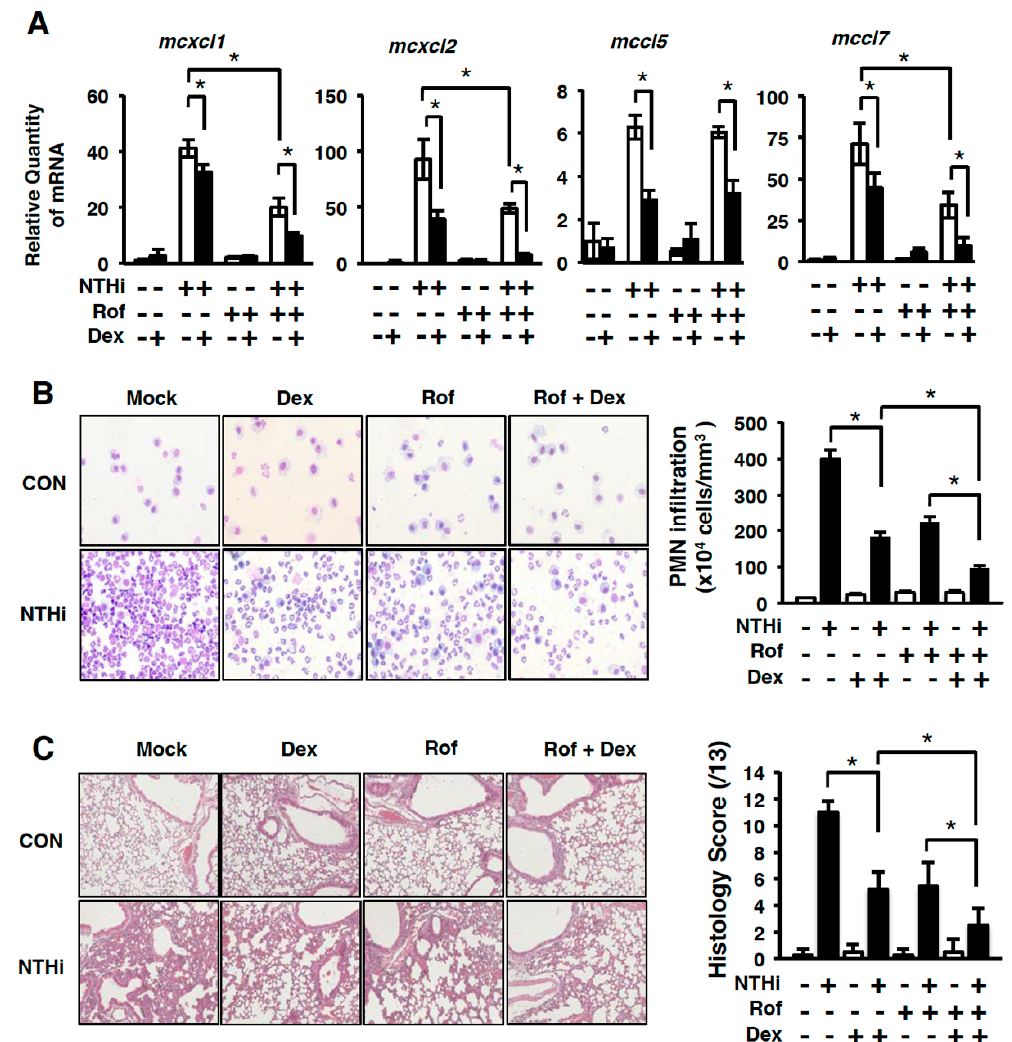
Figure 2. Dexamethasone suppresses NTHi-induced infiltration of polymorphonuclear neutrophils (PMNs) and inflammation in mouse lung in vivo. ( A ) Mice were inoculated with Rof (5 mg/kg i.p.) and/or Dex (2 mg/kg i.p.) for 2 h, followed by intratracheal inoculation with NTHi (5 × 10 7 CFU/lung). After 5 h, mRNA expressions of pro-inflammatory mediators in lung tissues were analyzed by Q-PCR. The relative quantity of mRNA is relative to a house keeping gene GAPDH . Data in ( A ) are mean ± S.D. ( n = 3); * p < 0.05. ( B ) Mice were inoculated with Rof (5 mg/kg i.p.) and/or Dex (2 mg/kg i.p.) for 2 h, followed by intratracheal inoculation with NTHi (5 × 10 7 CFU/lung) for 9 h. Bronchoalveolar lavage (BAL) fluid was harvested and cells from BAL fluid were then cytocentrifuged and stained with Diff-Quik staining kit. (Magnification: 100 × ). The number of PMN cells from BAL fluid was counted by using a hemocytometer under the microscope. Data are mean ± S.D. ( n = 3); * p < 0.05. ( C ) The lung tissues were collected 9 h after NTHi inoculation. Lung tissues were fixed with 10 % formalin, embedded with paraffin, and H&E stained (Magnification: 100 × ). Data are mean ± S.D. ( n = 3); * p < 0.05. All data are representative of three independent experiments.